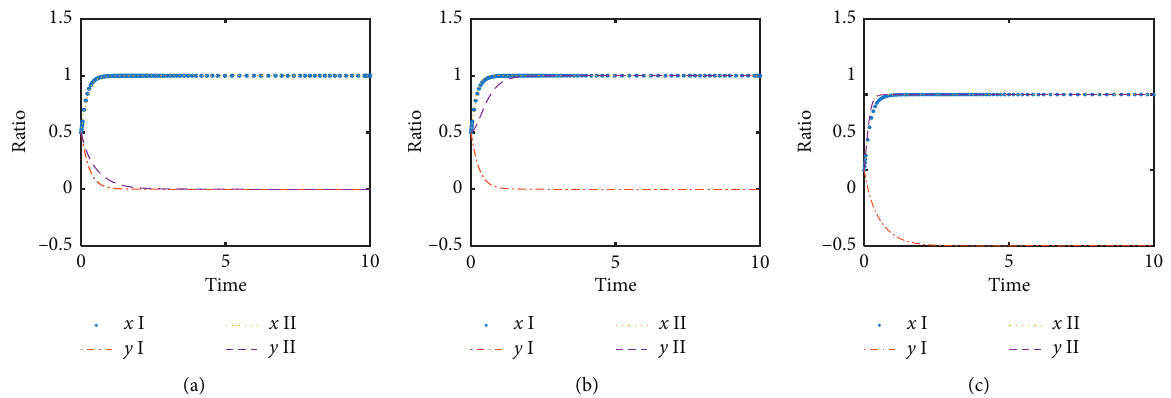
Figure 10: The influences of punishment for not sharing knowledge on the evolution system. (a) β (c) β g � 5 , β s �